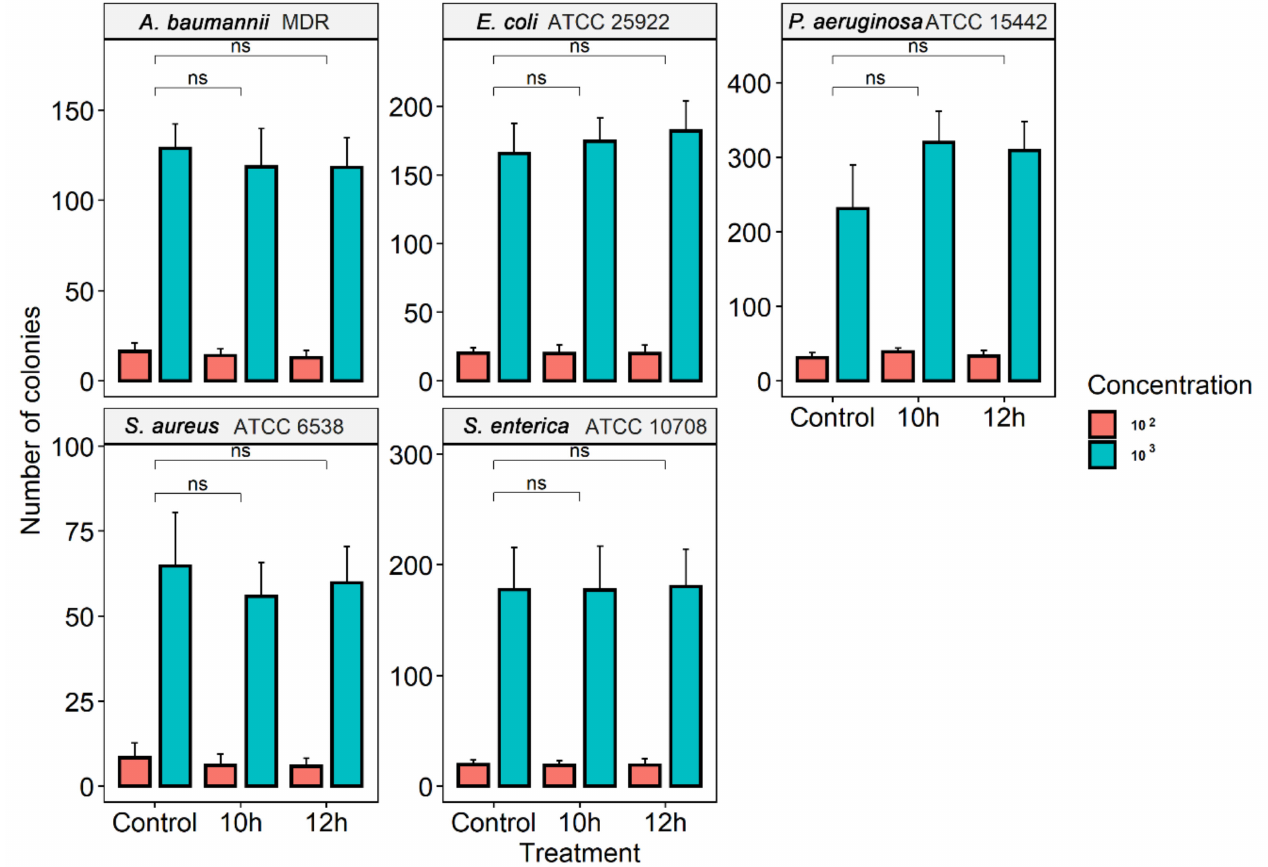
Figure 1. Counting the number of colonies in different species of bacteria ( A. baumannii MDR, S. aureus (ATCC 6538), S. enterica (ATCC 10708), E. coli (ATCC 25922), and P. aeruginosa (ATCC 15442). Quantification of the number of colonies was performed in the control group (without treatment) and in bacterial suspensions (10 3 and 10 2 CFU/mL) after exposure to O 3 for 10 h and 12 h; ns: statistically not significant using the t